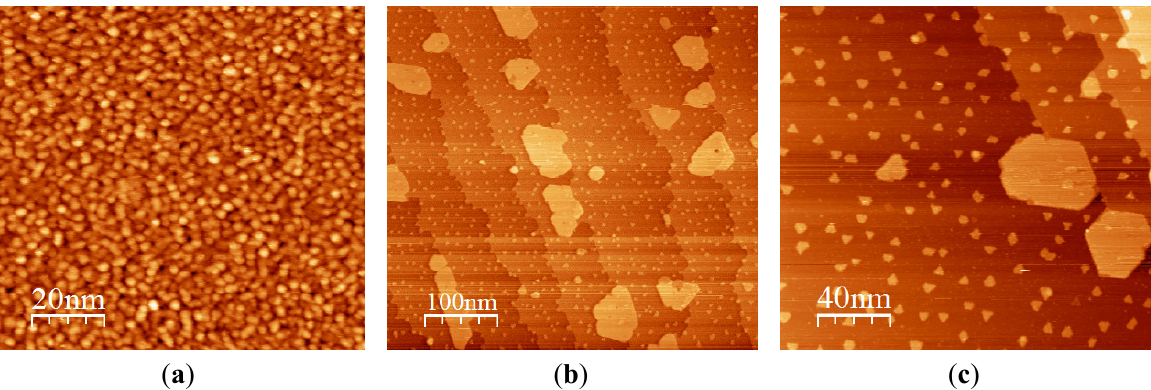
Figure 3. STM images showing the morphology of cerium oxide films on Pt(111): ( a ) 2 ML film after reactive growth at room temperature; ( b ) 0.2 ML film after reactive growth at room temperature and post-growth thermal treatment in O 2 at 1040 K; ( c ) zoom of sample ( b ). Modified with permission from Luches et al. [19]. Copyright ACS 2011.